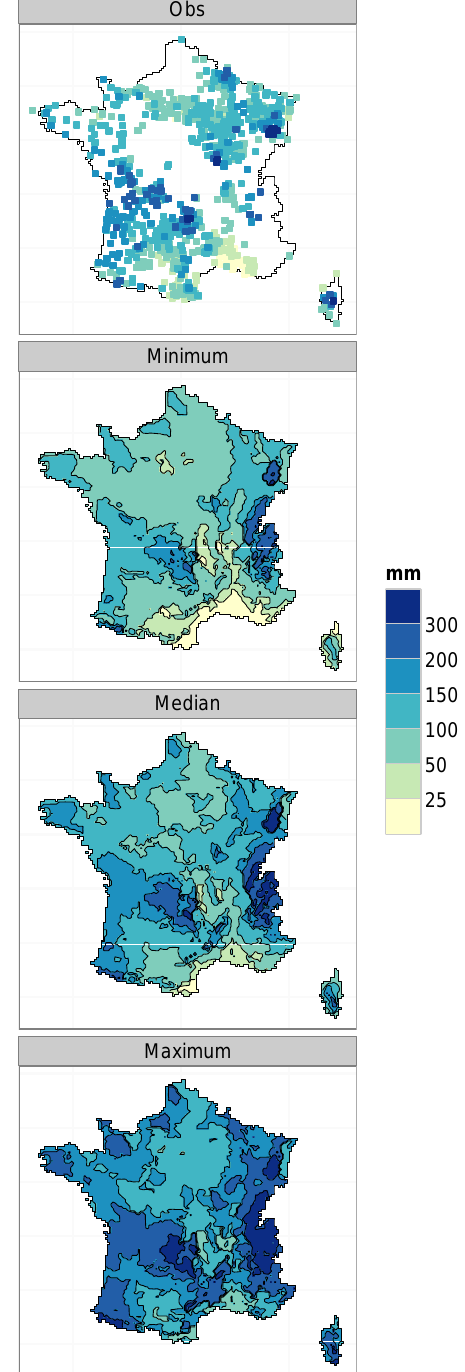
Figure 17. December 1909 precipitation. Top: observations cur- rently available from the Météo-France database. Below: minimum, median and maximum monthly precipitation from the 25 realiza- tions of the stepwise selection. Maximum values from observations, minimal, median and maximum simulations of 520, 409, 533 and 625mm